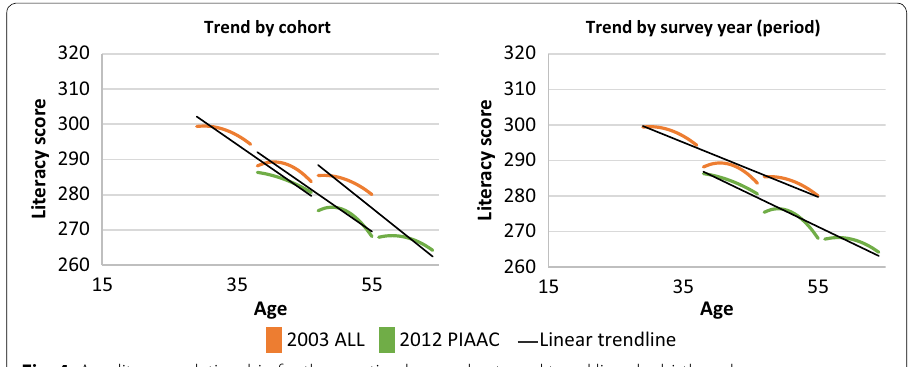
Fig. 4 Age-literacy relationship for three native-born cohorts and trend lines by birth and survey year, Canada, 2003 ALL and 2012 PIAAC. The predicted values of the literacy score are generated by regression models stratified by cohort and survey year. These models also include the following control variables: sex, province of residence, type of region (urban/rural), level of education, knowledge and use of official languages, mother’s level of education, practice of literacy activities at home, and use of writing skills at work (and labour market participation